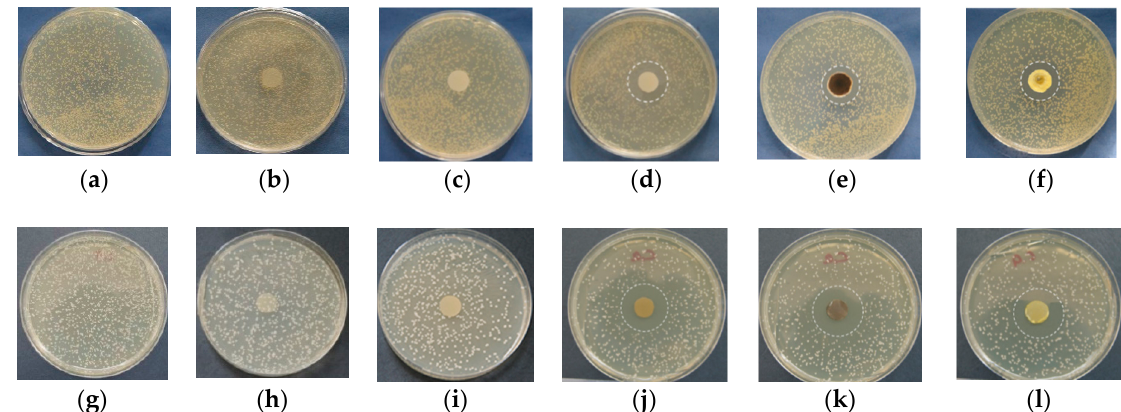
Figure 8. Digital images of the zones of inhibition against S. aureus ( a – f ) and C. albicans ( g – l ), detected after 24 h (for S. aureus ) and 48 h contact (for C. albicans ) of the fibrous materials with the bacterial or fungal cells. a,g— S. aureus or C. albicans , ( b , h )—crPVA mat, c,i—cr(PVA/Ch) mat, ( d , j )—cr(PVA/Ch)/SQ (10 wt% SQ) mat, ( e , k )—Fe 3+ complexes of cr(PVA/Ch)/SQ (10 wt% SQ) mat, ( f , l )—Cu 2+ complexes of cr(PVA/Ch)/SQ (10 wt% SQ) mat.